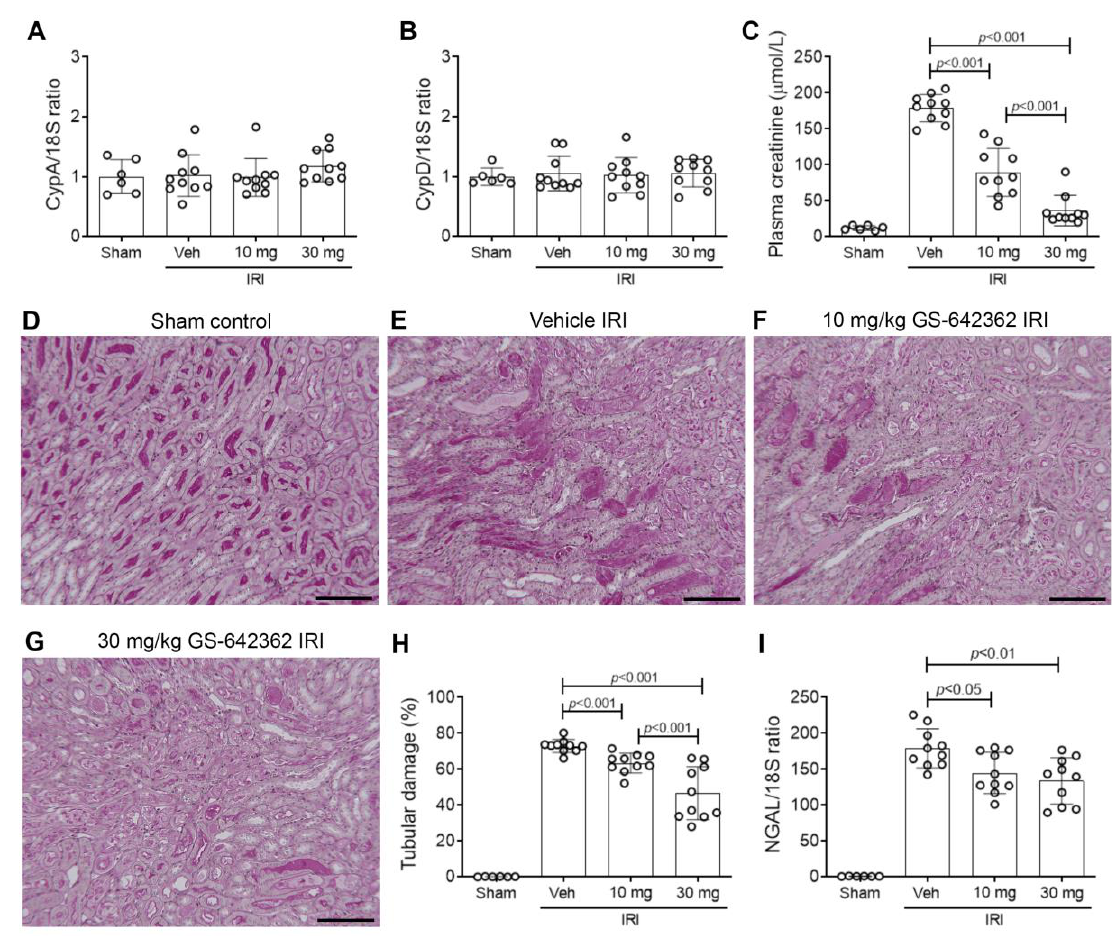
Figure 2. Cyclophilin expression, renal function and tubular damage in renal ischemia/reperfusion injury (IRI). Groups of mice (n = 10) were treated with vehicle, 10 or 30 mg/kg/BID GS-642462 and compared to sham controls (n = 6). RT-PCR for mRNA levels of ( A ) CypA and ( B ) CypD. ( C ) Plasma creatinine levels. ( D – G ) Periodic-acid-Schiff-stained kidney sections. ( D ) Sham operated showing normal kidney structure. ( E ) Vehicle-treated IRI showing severe tubular damage in the outer medulla featuring tubular cell loss/sloughing and cast formation. ( F ) IRI treated with 10 mg/kg GS-642362 shows extensive tubular damage. ( G ) IRI treated with 30 mg/kg GS-642362 shows lesser, but still significant, tubular damage. Bar = 200 µ m. ( H ) Graph of tubular damage. ( I ) RT-PCR for mRNA levels of the tubular damage marker,